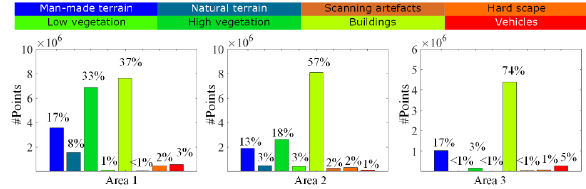
Figure 2. Ratio of annotated semantic classes in the TUM-MLS-2016 benchmark